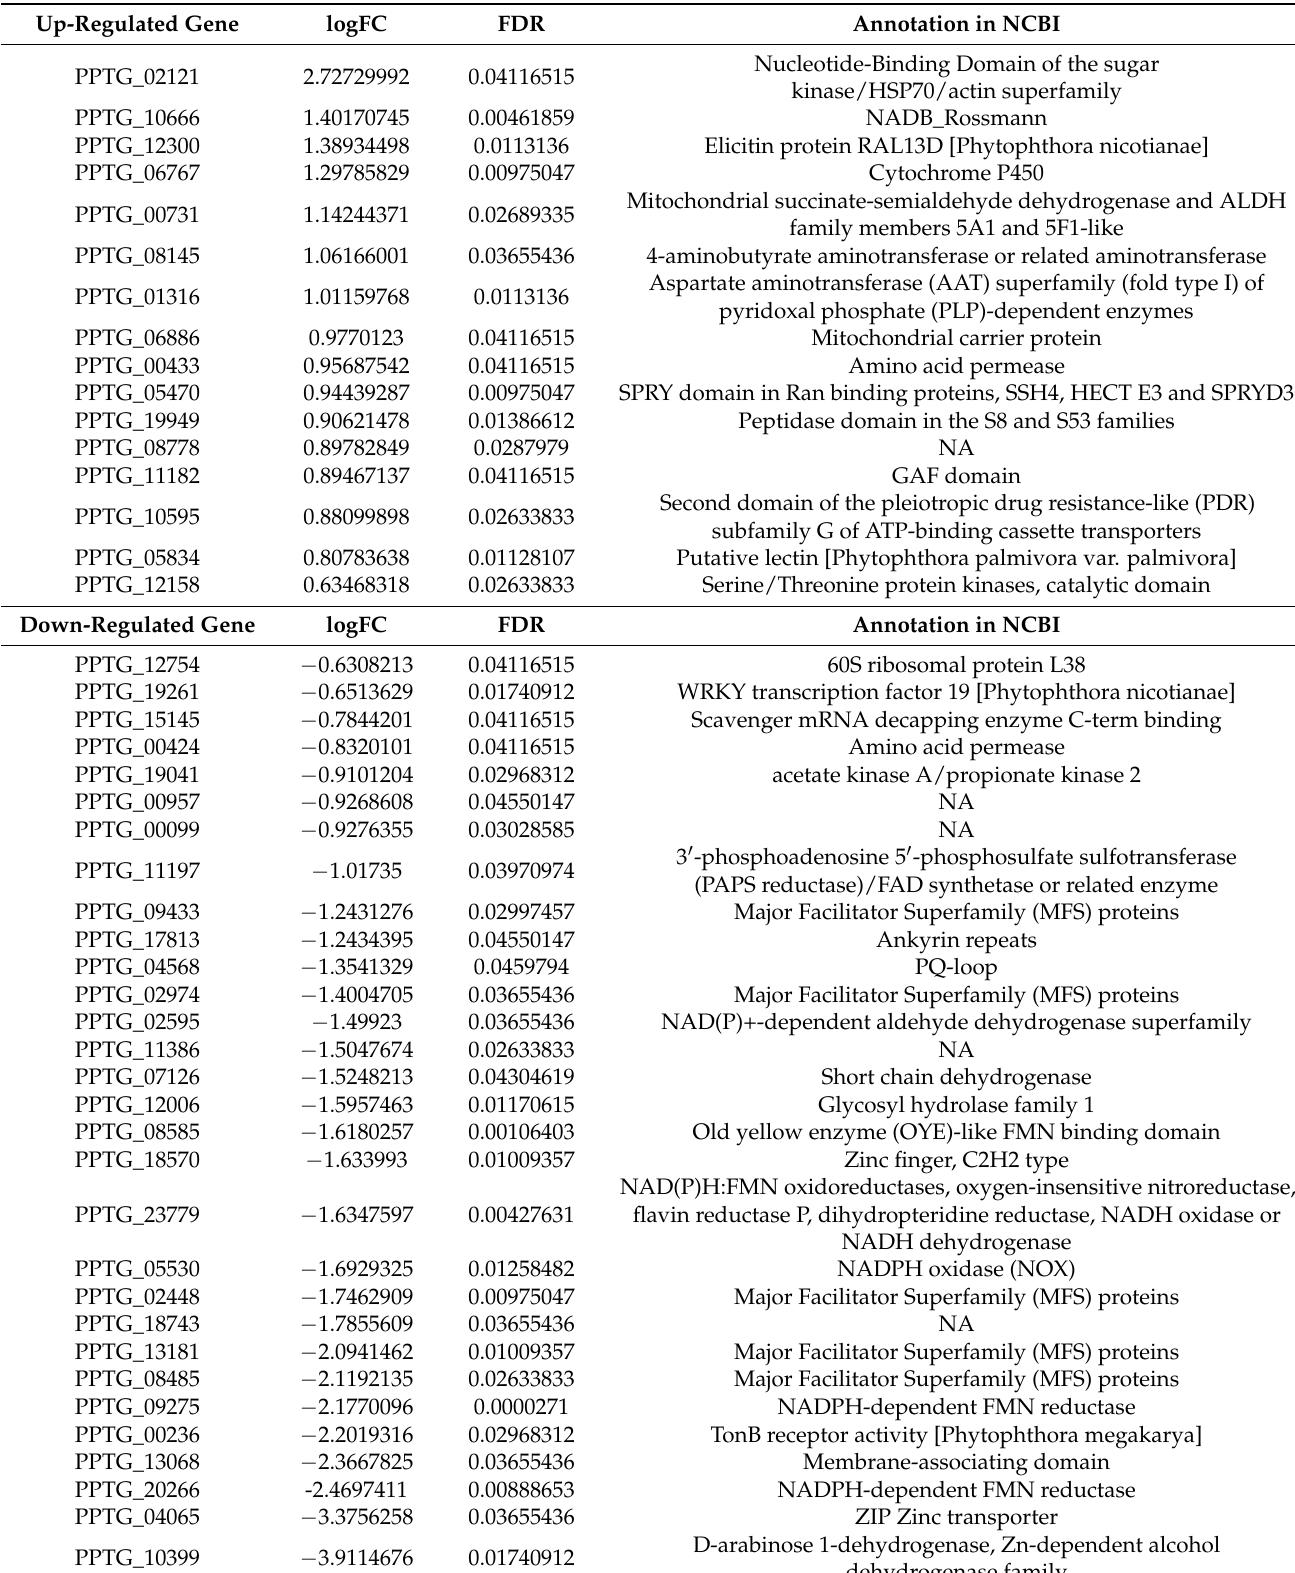
Table 3. DEGs identified in the Wz-Wz isolate of P. nicotianae by comparing transcriptomes in inoculated K 326 Wz/Wz to inoculated